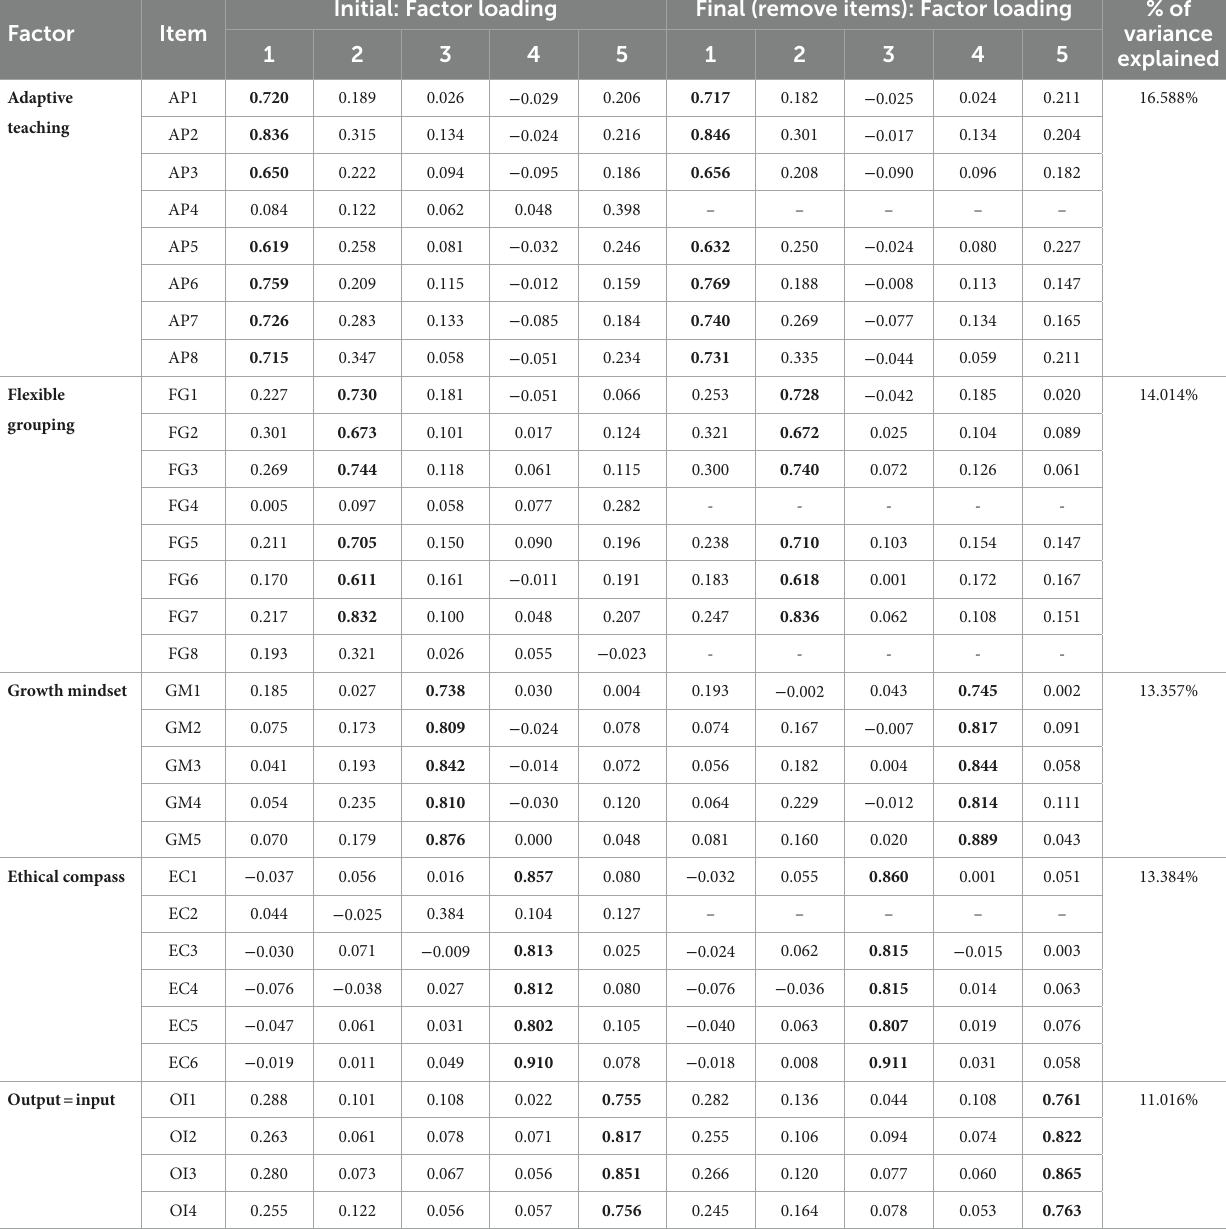
TABLE 3 The factor loadings in EFA for the initial and final round.